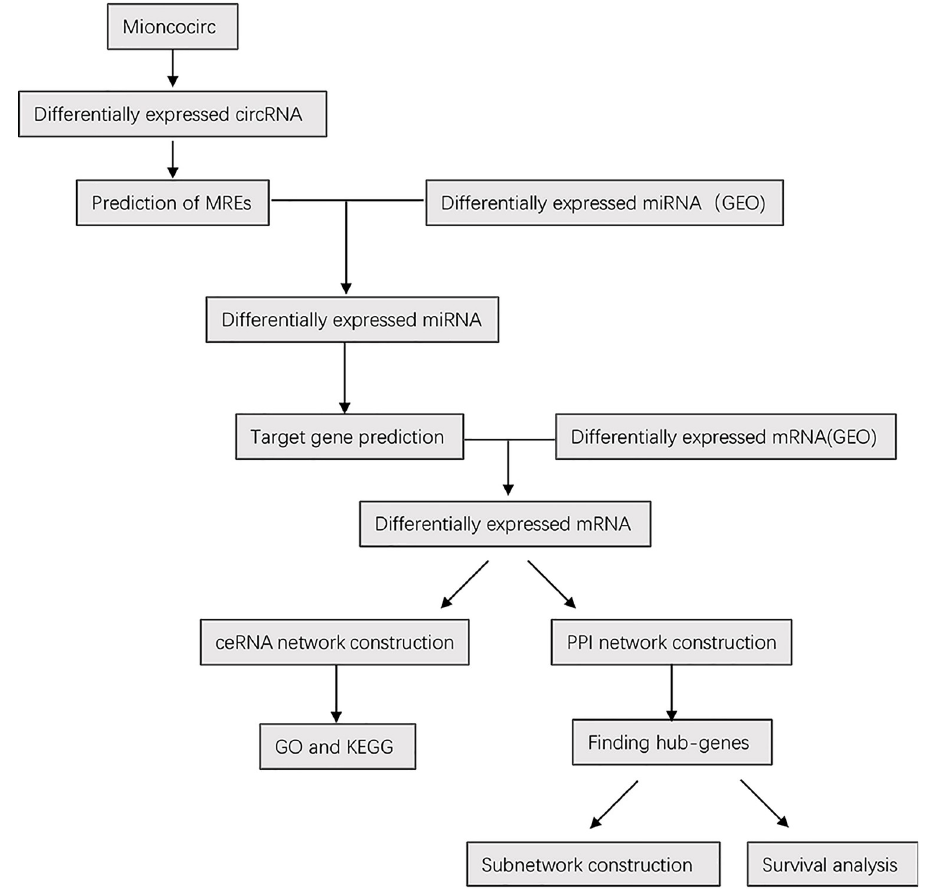
Fig 1. Flow diagram of the ceRNA